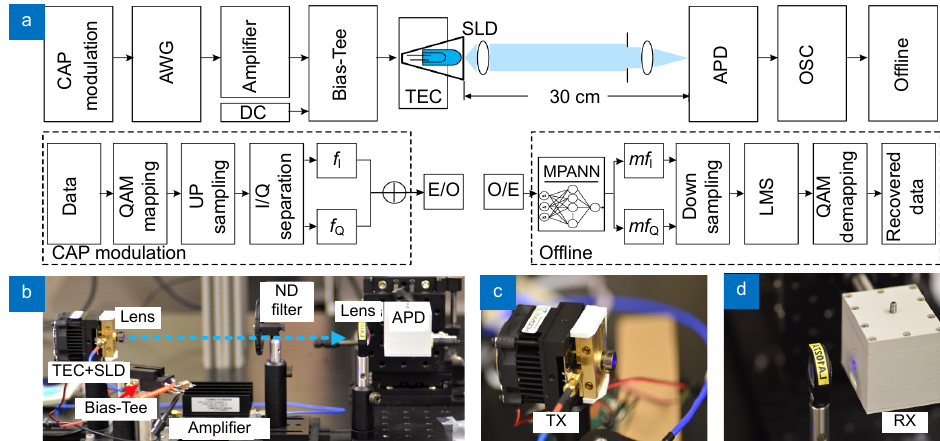
Fig. 3 | VLC experimental setup. ( a ) Schematic of the VLC system and the DNN-aided CAP post-equalizer. ( b ) Image of the optical channel and components. ( c ) and ( d ) are detail images of the transmitter (TX) and receiver (RX) units. CAP: Carrierless amplitude and phase. AWG: Arbitrary waveform generator. DC: Direct current. TEC: Thermoelectric cooler. APD: Avalanche photodiode. OSC: